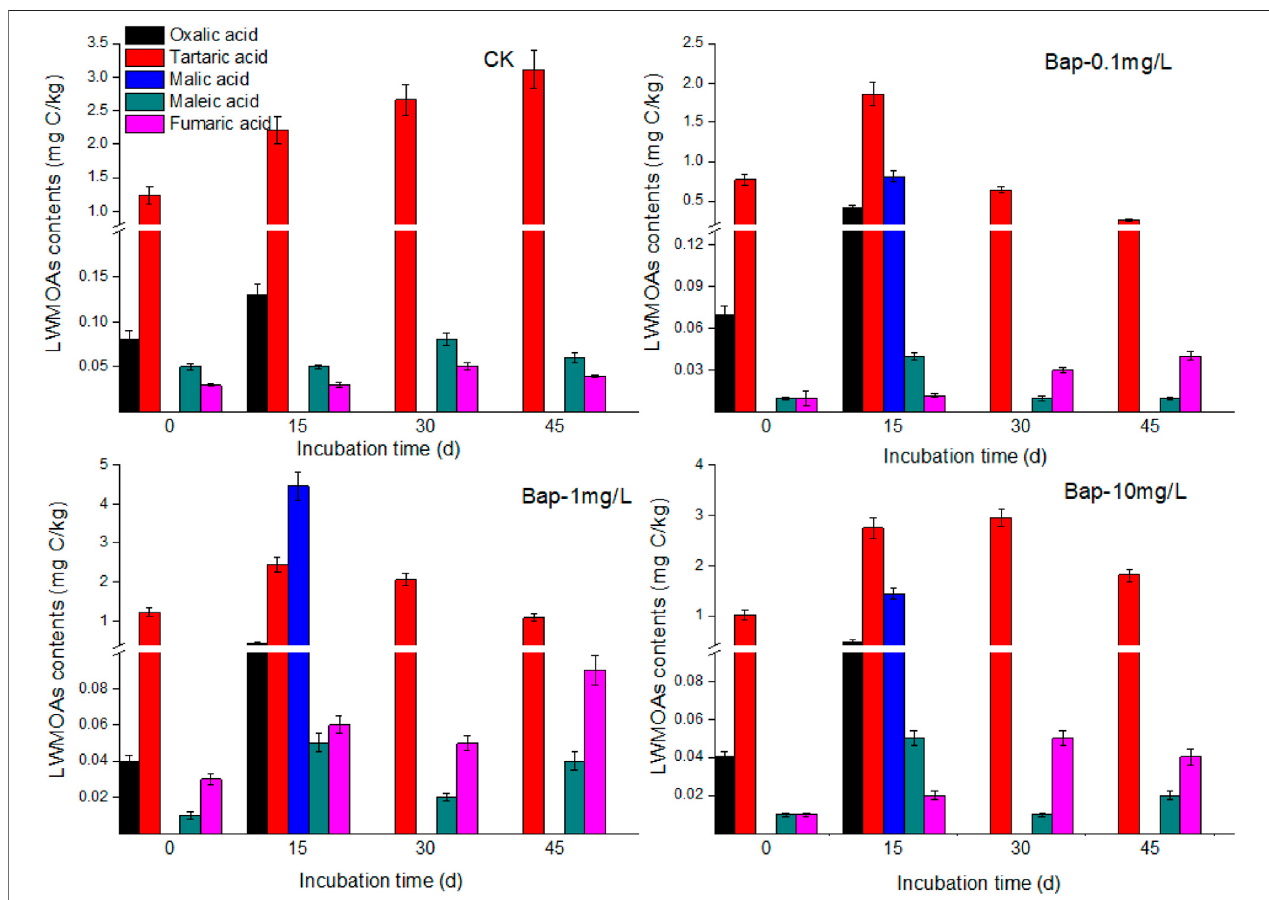
FIGURE 6 | The change of LWMOAs in root exudates under Bap tress.